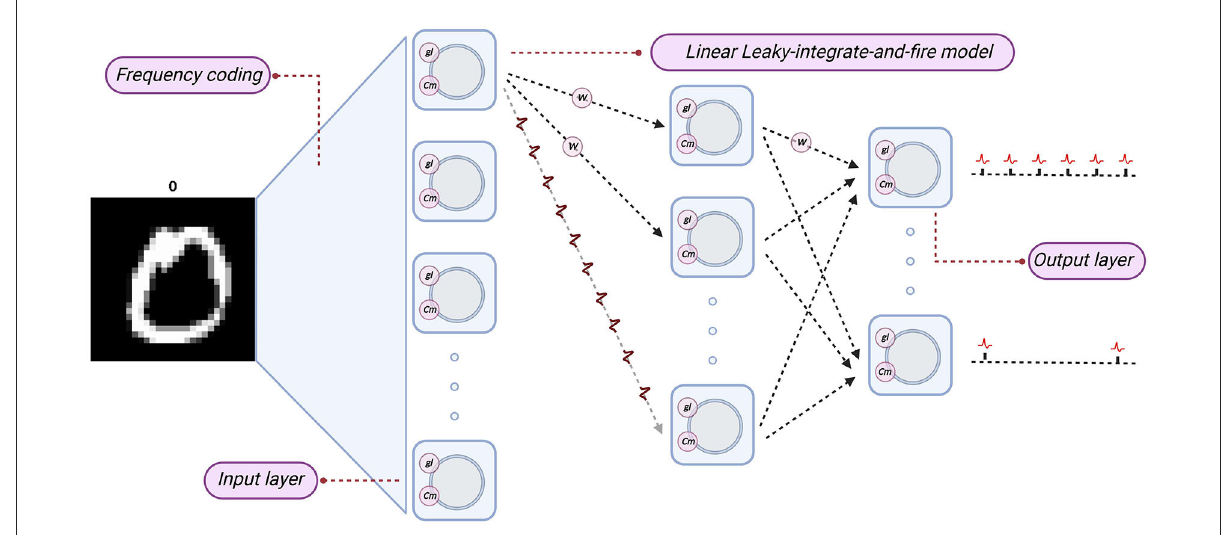
FIGURE10 The structure of LIF-SNN. The network structure of SNN is the same as that of ANN, and the nodes are replaced by Linear LIF model. The subscript of the node with the largest number of action potentials in the output layer is taken as the output of the network.